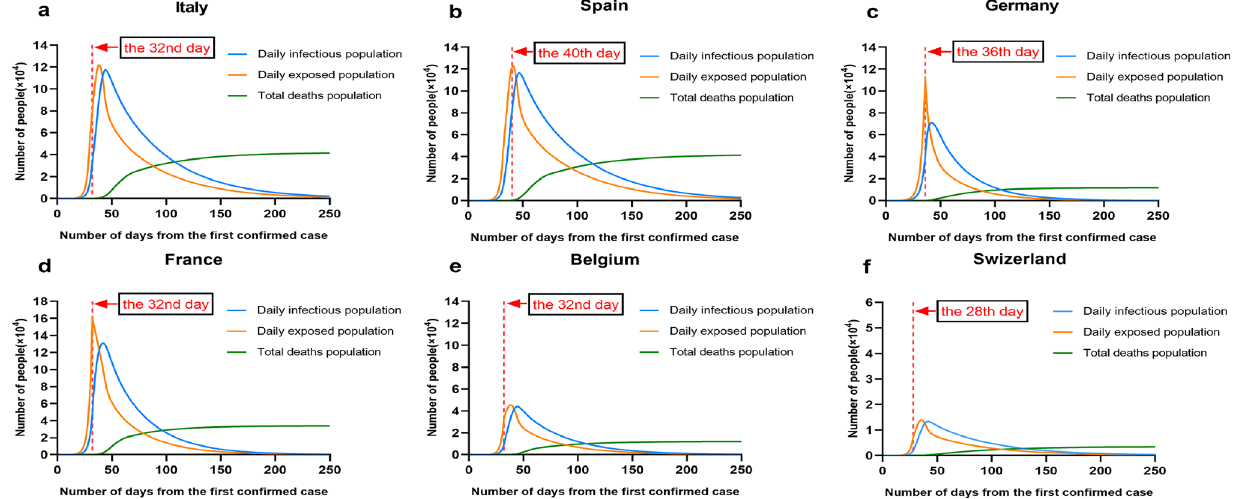
Figure 3. Illustration of forecasting infections in 6 European countries (Italy, Spain, Germany, France, Belgium and Switzerland) by implementing suppression intervention.